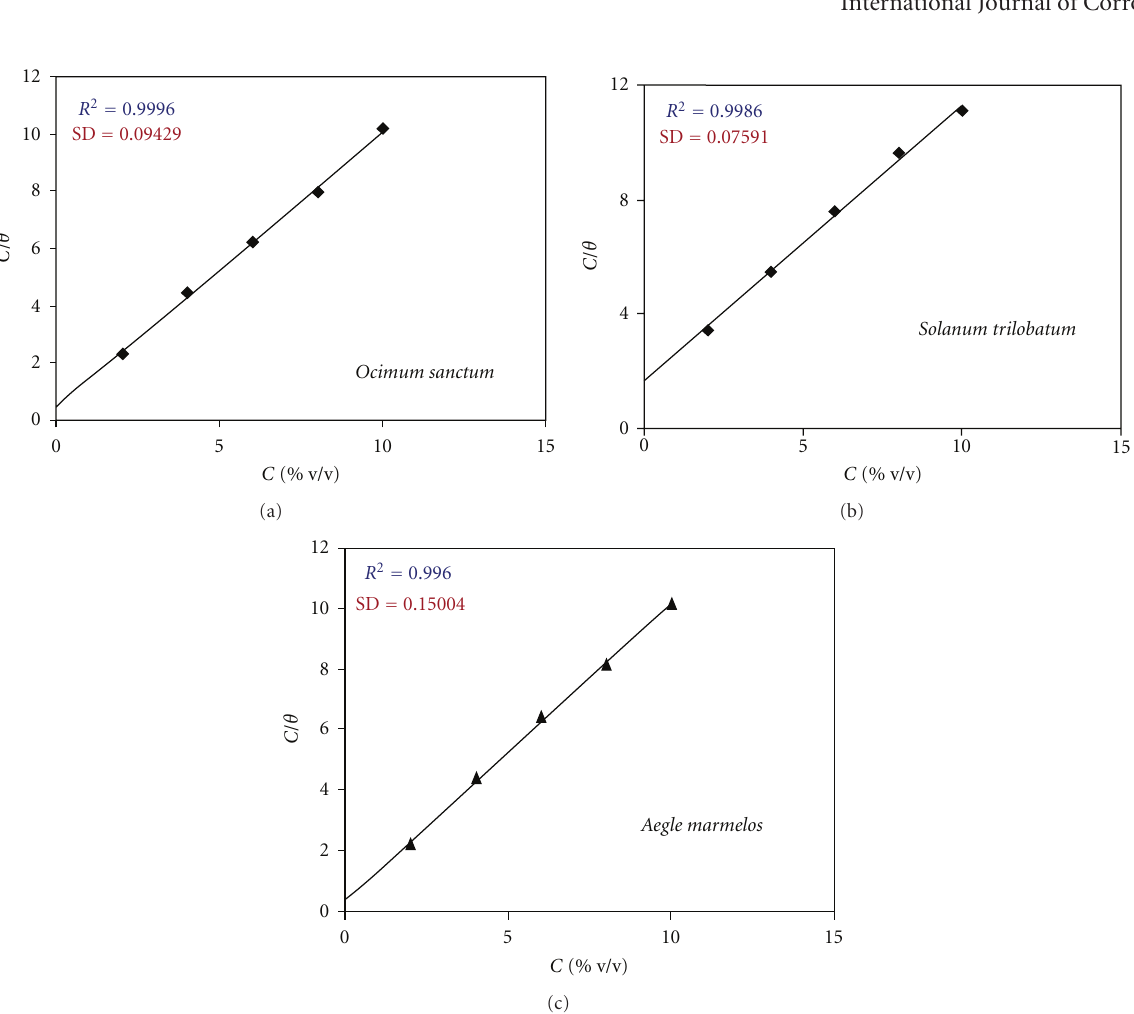
Figure 8: Langmuir adsorption isotherm plot for the adsorption of various concentrations of the plant extracts on the surface of mild steel in 1N HCl solution.